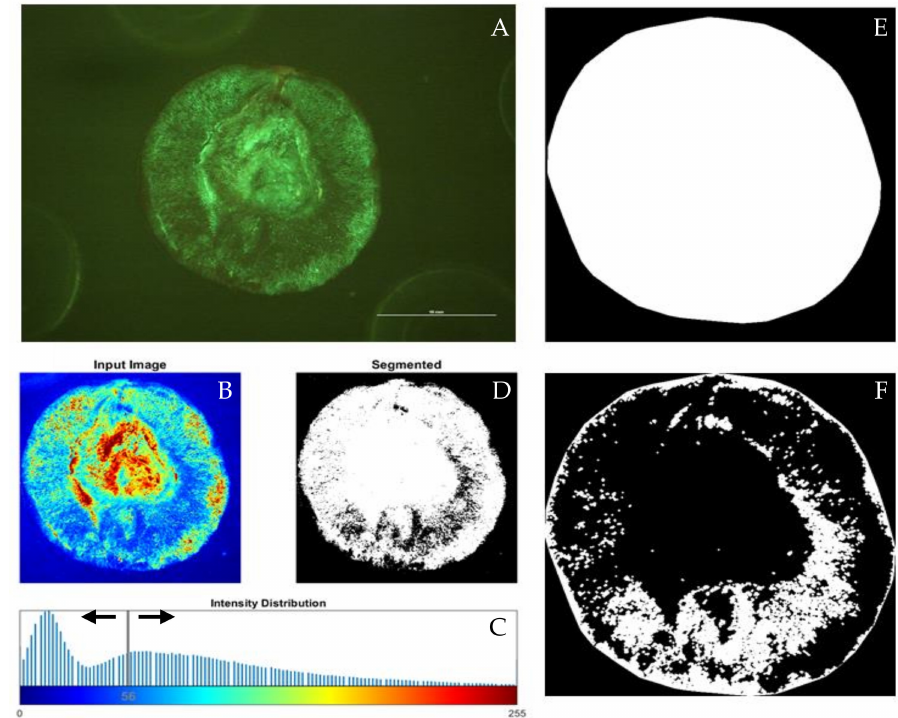
Figure 1. Computer vision analysis of digital images obtained from fluorescein diacetate (FDA) stained Pinot Noir berries. ( A ) original FDA fluorescent image; ( B ) intensity image to enhance living tissue; ( C ) thresholding to adjust binarization using a sliding line; ( D ) living tissue (LT) assessment (white) and dead tissue (black); ( E ) binary image of the whole contour of berry for percentage calculation; ( F ) binary image of dead tissue assessment (DT), which for this specific image was